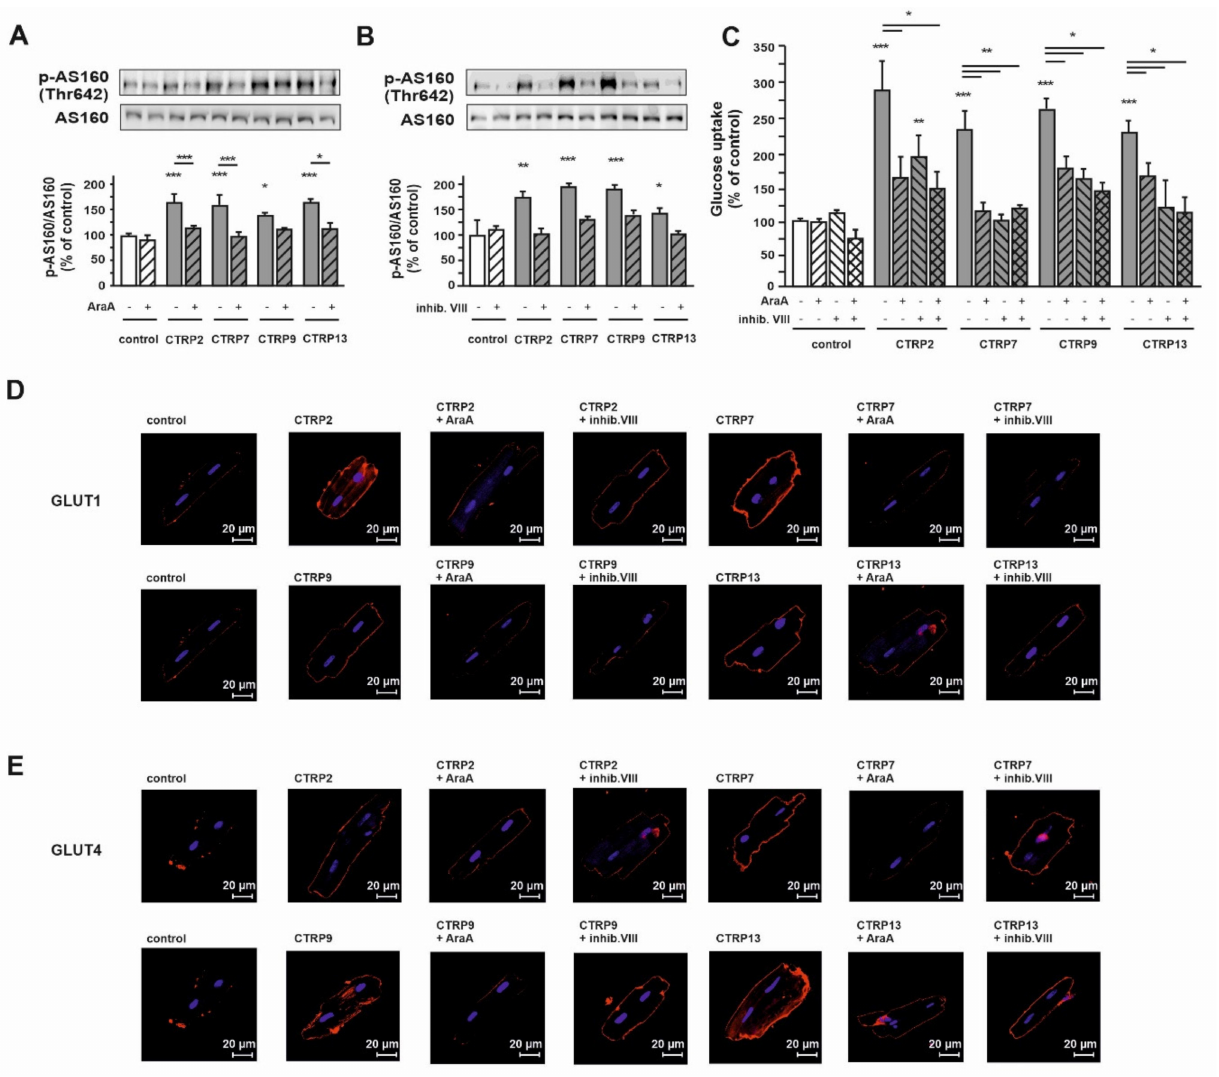
Figure 4. Role of AMPK and Akt inhibition on the effects of CTRP-induced glucose uptake in adult rat cardiomyocytes. AS160 ( A , B ) and glucose uptake ( C ) were investigated after preincubation with ( A , C ) AraA (500 µ M) or ( B , C ) Akt inhibitor VIII (0.1 µ M) for 30 min, followed by 10 min ( A , B ) or one hour ( C ) treatment with CTRP2, CTRP7, CTRP9 and/or CTRP13. Total AS160 served as loading control in A and B. Data are mean ± SEM from 5 independent experiments with 2 biological replicates, each. * p < 0.05, ** p < 0.01, *** p < 0.001 vs. untreated control, unless otherwise indicated. ( D , E ) Following AraA or VIII preincubation for 30 min and stimulation of CTRP2, CTRP7, CTRP9 and CTRP13 for 20 min, GLUT1 ( D ) and GLUT4 ( E ) were analyzed by confocal microscopy. Data are mean ± SEM from 5 independent experiments with 1 biological replicate,